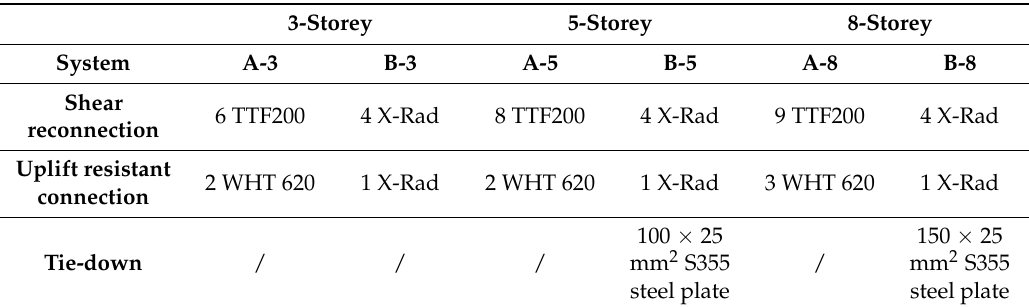
Table 2. Design pattern of connections for single shear wall adopted in type A and type B building